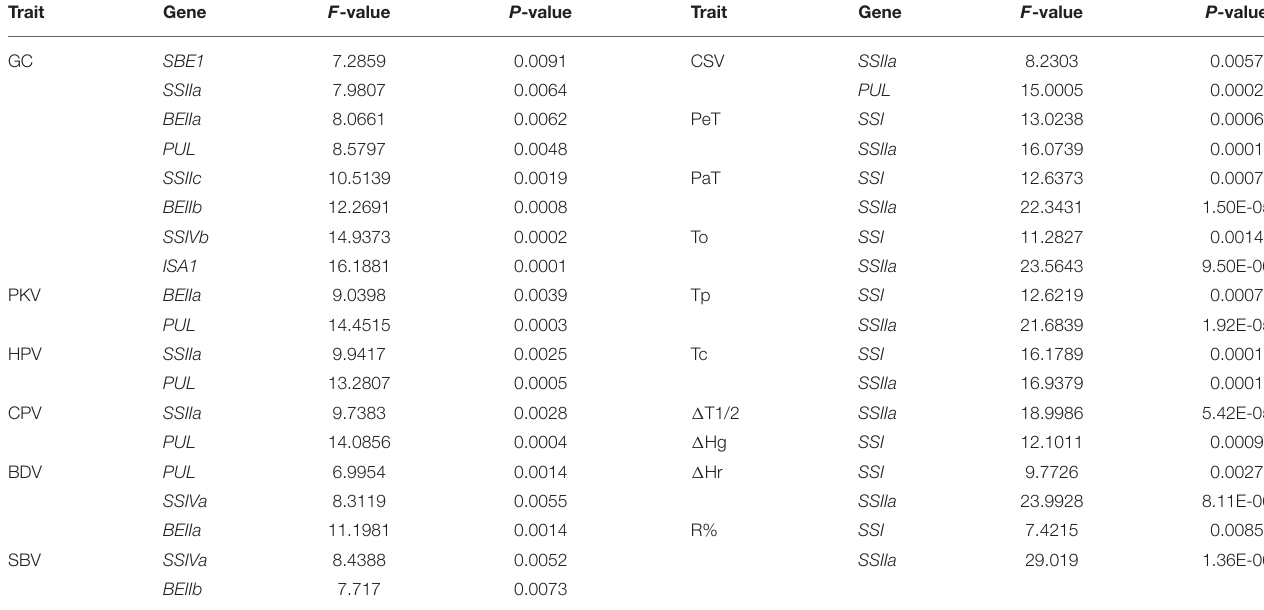
TABLE 4 | The results of TGAS of glutinous rice quality. Trait